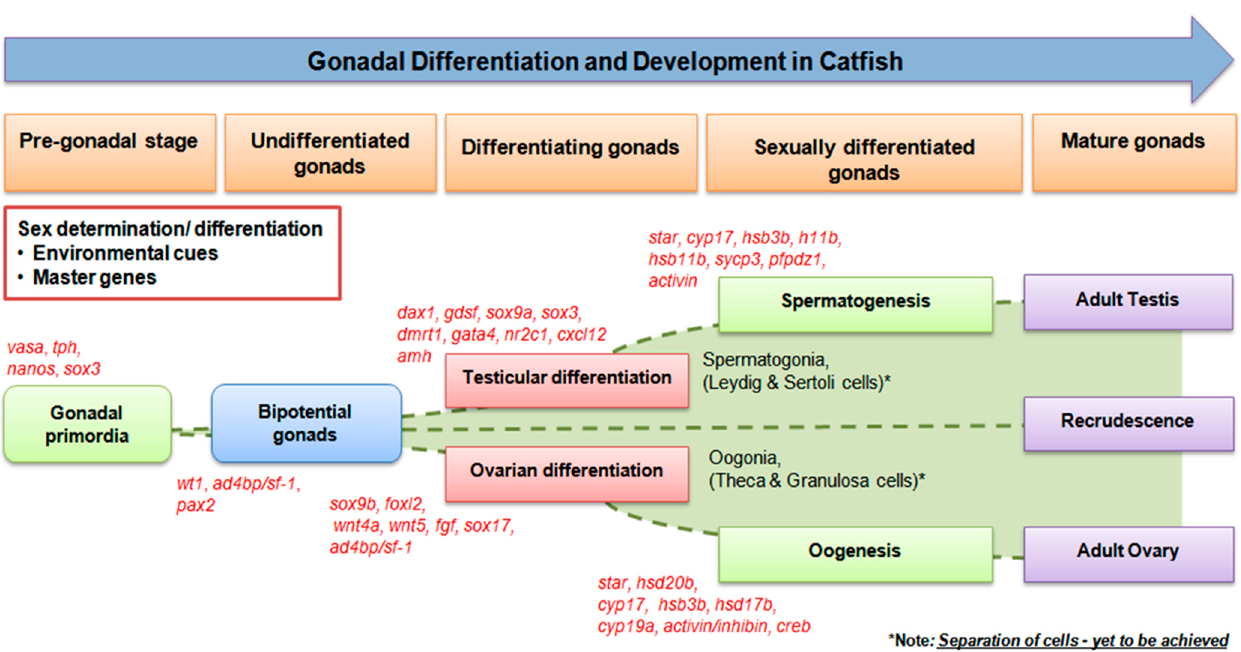
Figure 2. Orchestration of various marker genes/factors during different stages of gametogenesis/gonadogenesis in cat- fish.